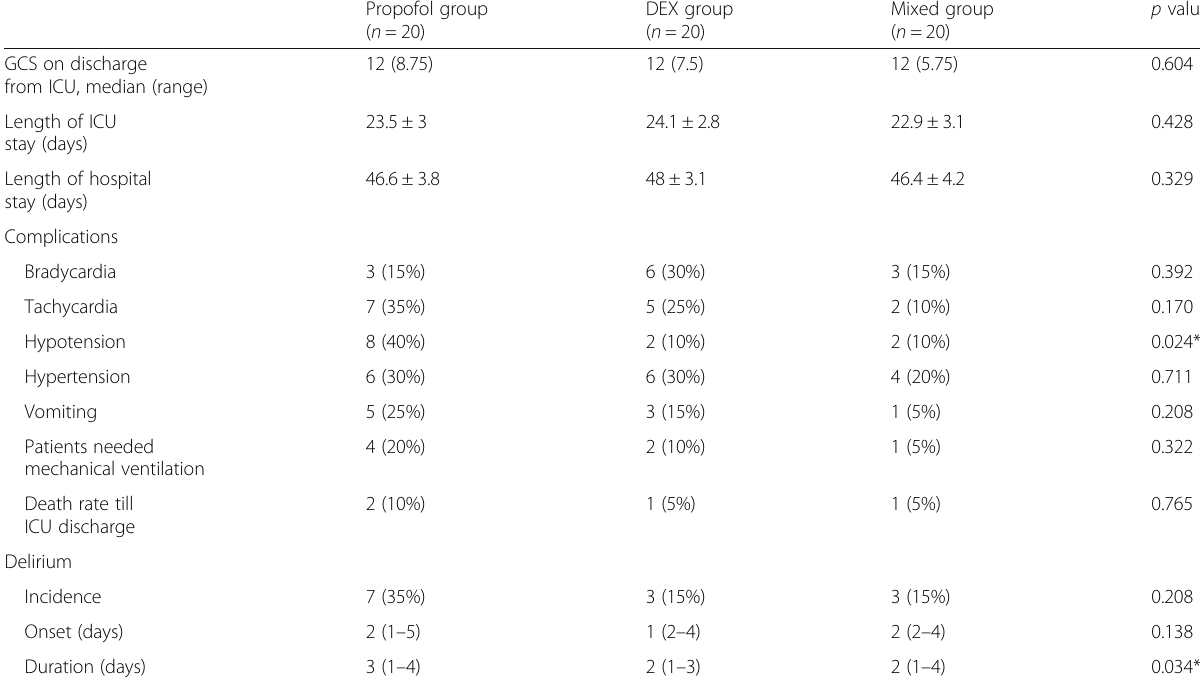
Table 5 Clinical outcome, length of stay, complications, and delirium in the studied groups